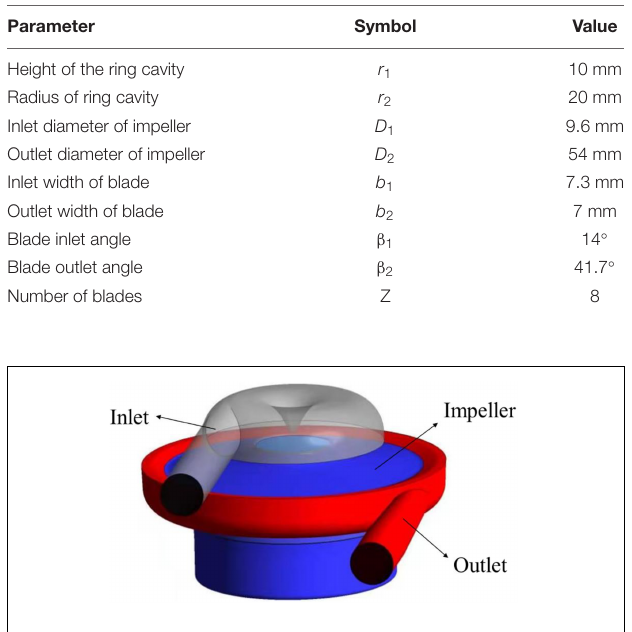
FIGURE 3 | Schematic of computational domain for the portable blood pump.